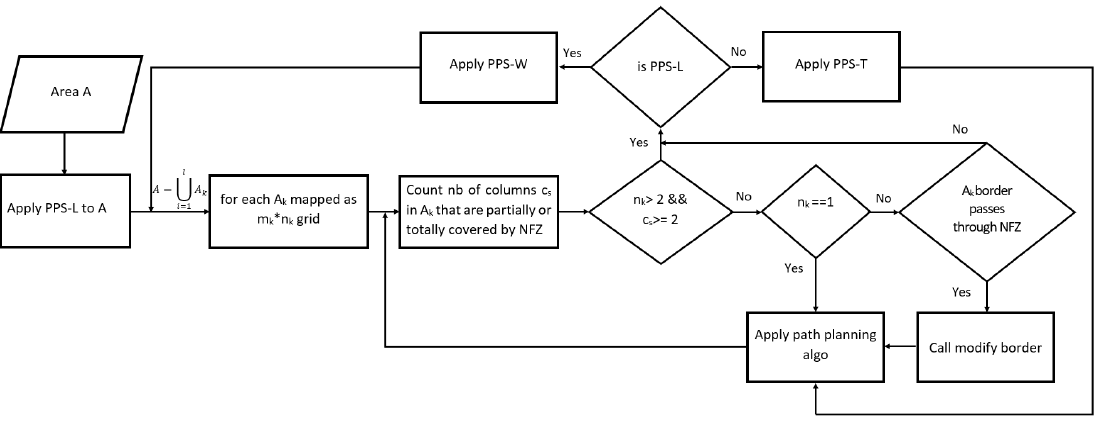
Figure 17. PPS flow chart in the presence of NFZ and using approximate cellular